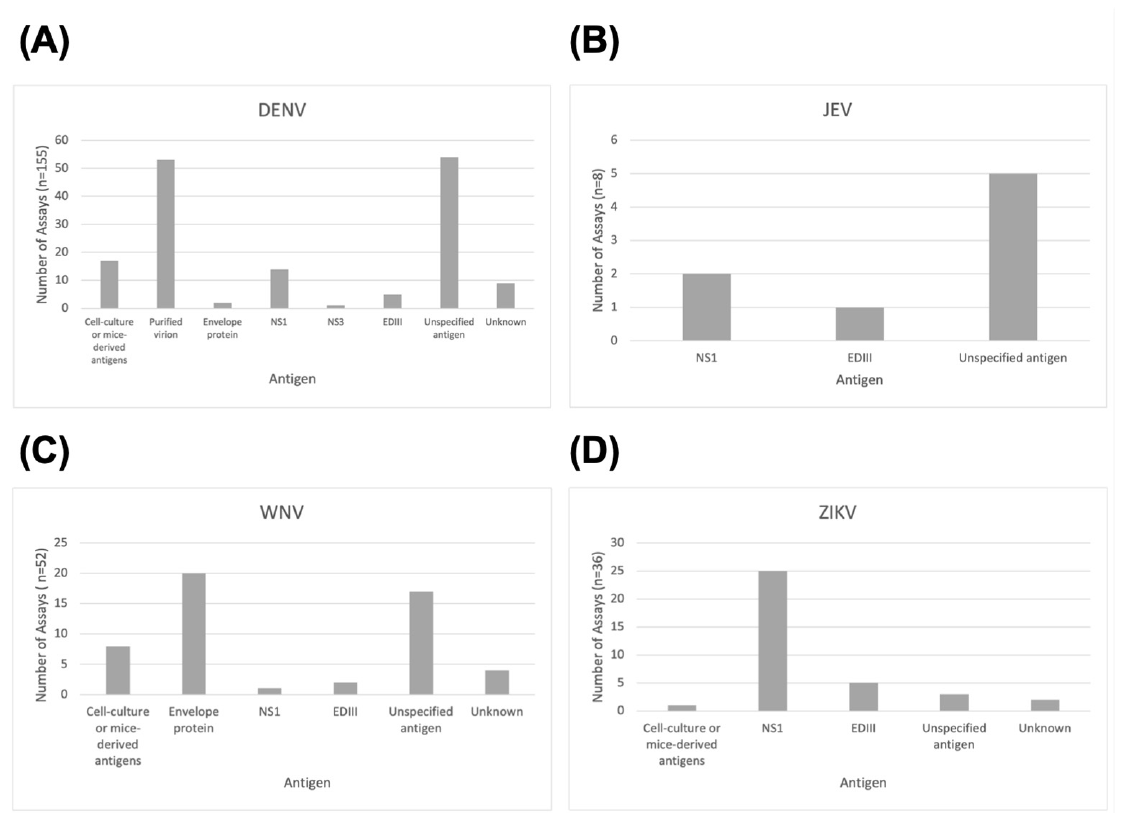
Figure 4. Distribution of ELISA antigens by virus: ( A ) DENV, ( B ) JEV, ( C ) WNV, ( D ) ZIKV.